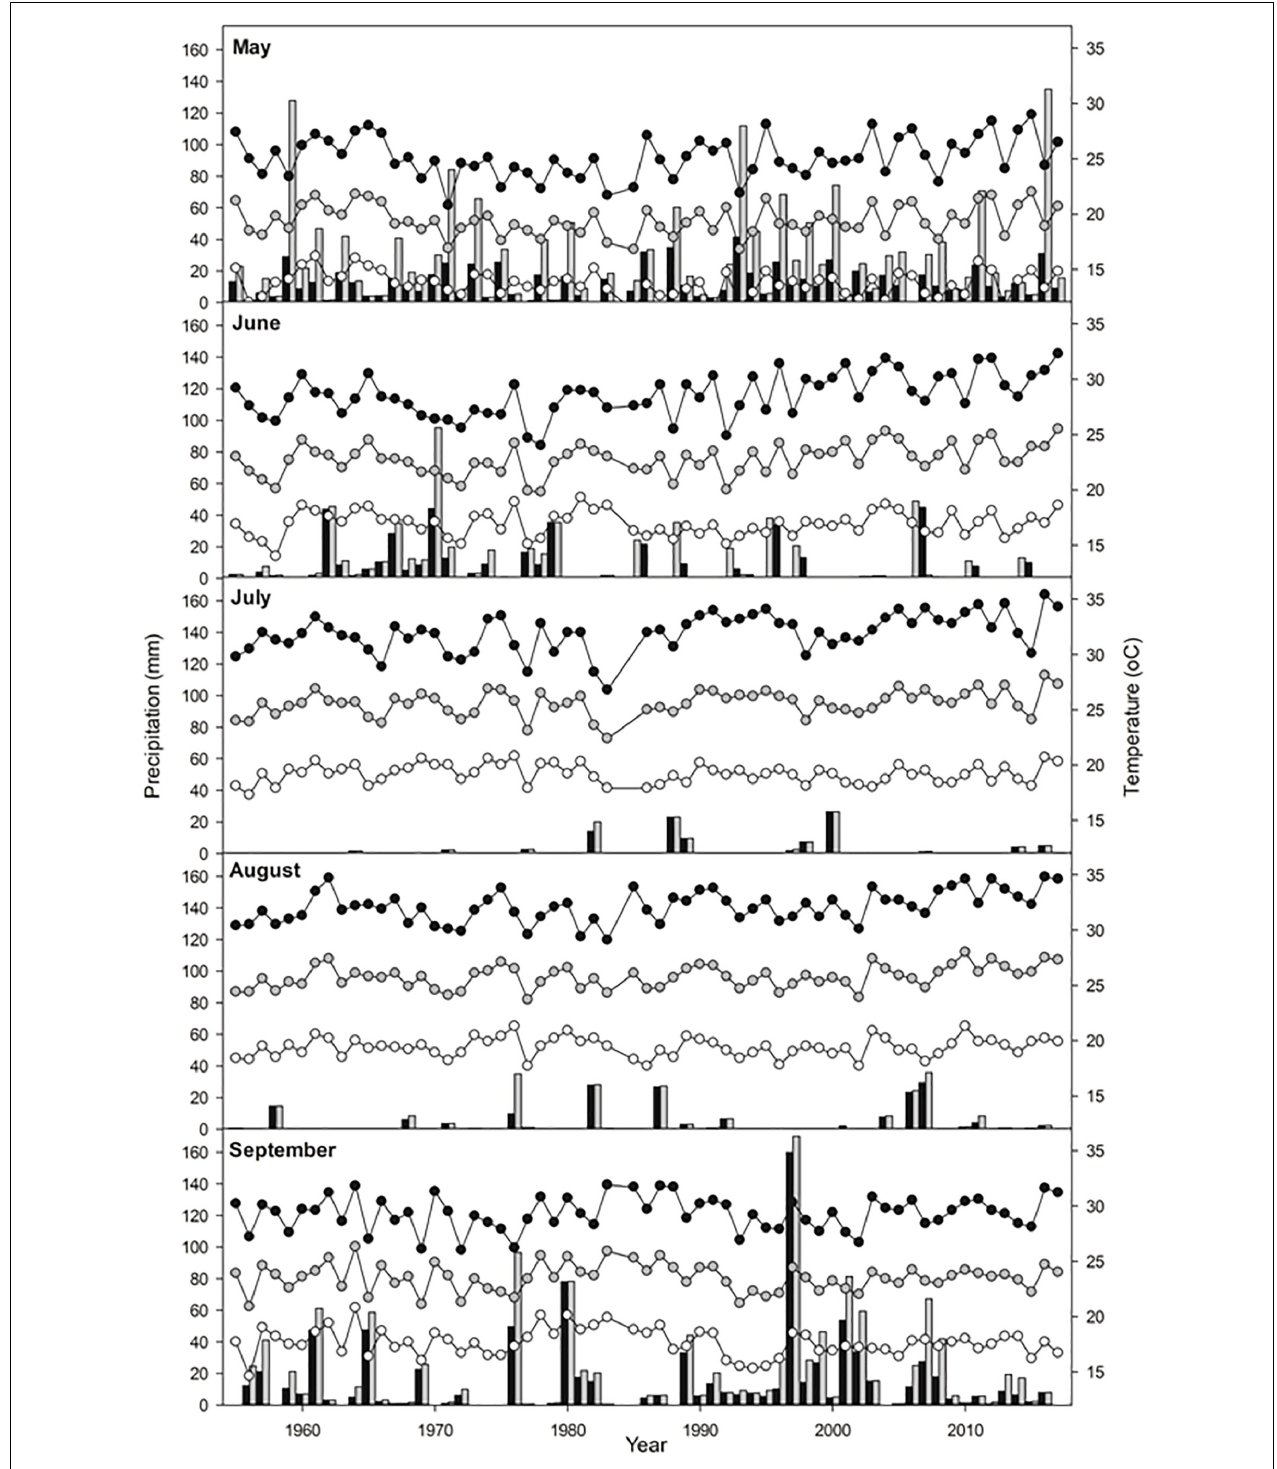
FIGURE 1 | Meteorological data in May, June, July, August, and September from 1955 to 2017 in Southwest Iberian Peninsula. Mean monthly precipitation (black bars), maximum daily precipitation (gray bars), mean maximum temperatures (black circles), mean average temperatures (gray circles) and mean minimum temperatures (white